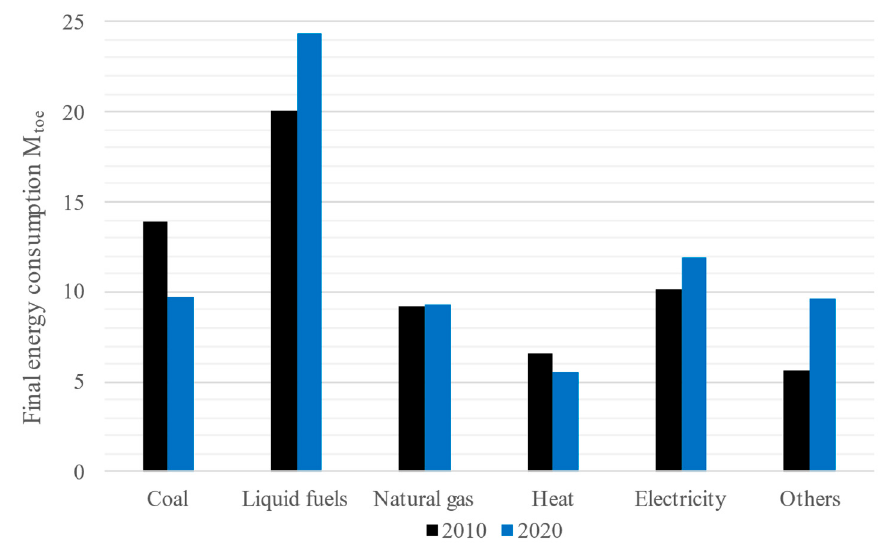
Figure 1. Structure of final energy consumption by carrier in 2010 and 2020 in Poland.